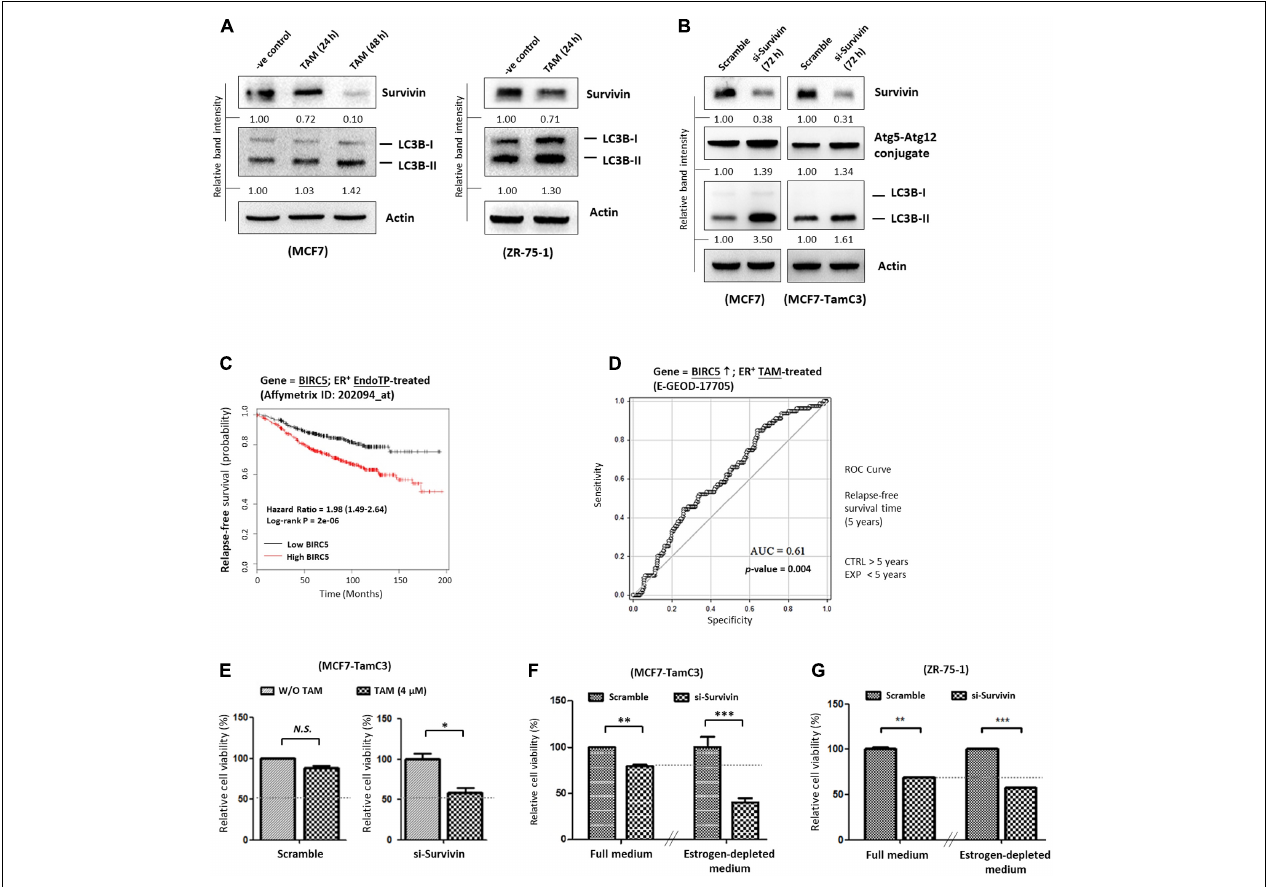
FIGURE 4 | Overexpression of survivin contributes to the induction of hormone therapy resistance in the ER + HDAC2-upregulated breast cancer cells. (A) MCF7 and ZR-75-1 cells were treated with 4 µ M tamoxifen for 24–48 h and expression of survivin and conversion of LC3B-II were determined by Western blotting. (B) MCF7 and MCF7-TamC3 cells were transfected with either scramble siRNA or survivin siRNA for 72 h. Expression of survivin, Atg5-Atg12 conjugate, and conversion of LC3B-II were determined by Western blotting. Actin was used as an internal control. (C) Kaplan–Meier survival estimates of high (red line) or low (black line) survivin expression in ER + endocrine therapy-treated breast cancer. (D) ROC analysis of BIRC5 (survivin) for 5-year relapse-free survival on ER + tamoxifen-treatment breast cancer patients. (E) MCF7-TamC3 cells were pre-transfected with either scramble siRNA or survivin siRNA for 24 h and co-treated with or without tamoxifen for 72 h. Cell viability was assessed by the MTT assay. (F) MCF7-TamC3 cells were pre-transfected with either scramble siRNA or survivin siRNA for 24 h and subsequently cultured under either estrogen-containing (Full) or estrogen-deprived conditions for 72 h. (G) ZR-75-1 cells were pre-transfected with either scramble siRNA or survivin siRNA for 24 h and subsequently cultured under either estrogen-containing (Full) or estrogen-deprived conditions for 72 h. Cell viability was assessed by the MTT assay. “ ∗ ” , “ ∗∗ ” , and “ ∗∗∗ ” denote a statistical significance ( P < 0.05, P < 0.01, and P < 0.001, respectively) between the testing